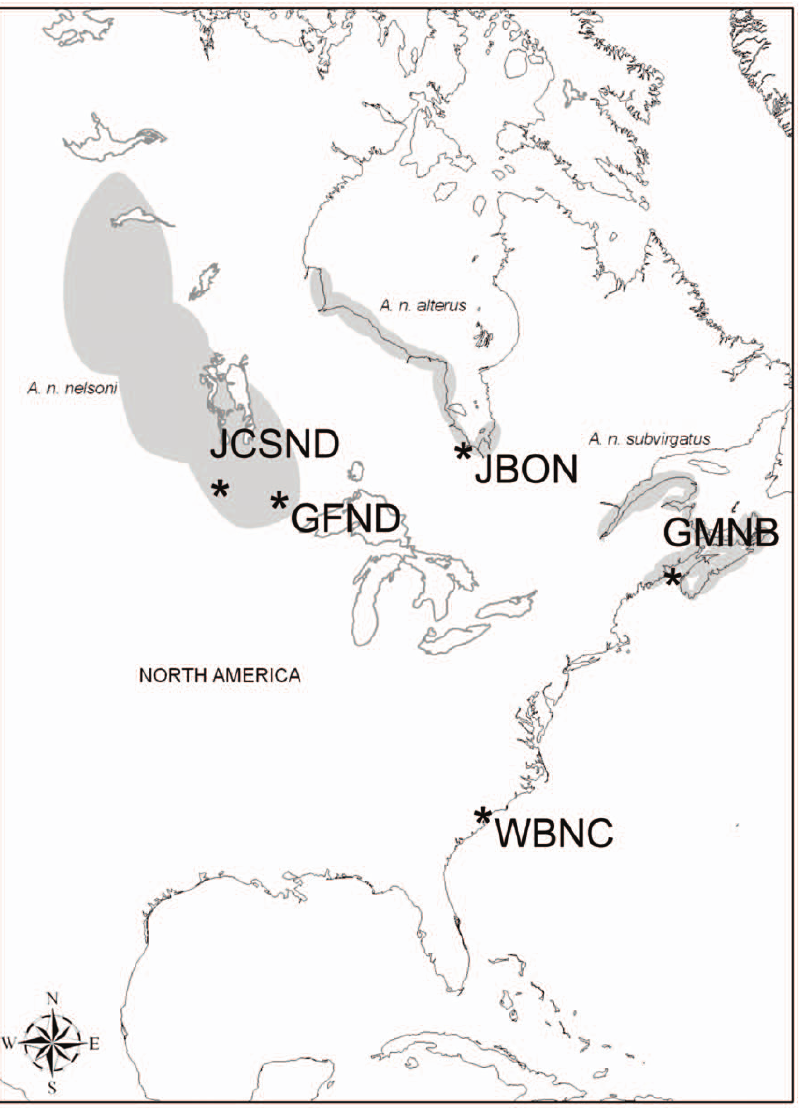
Figure 1. Map of breeding ranges (gray shading) for each subspecies of Nelson’s Sparrow. Capture locations are noted with asterisks (*). GFND represents captures near Grand Forks, ND, USA (47 u 54 9 7.90 0 N, 97 u 17 9 55.31 0 W); GMNB represents captures from Grand Manan Island, New Brunswick (44 u 42 9 0.00 0 N, 66 u 47 9 60.00 0 W); JBON represents captures from the shore of James Bay north of Moosonee, Ontario, Canada (51 u 21 9 36.53 0 N, 80 u 25 9 27.79 0 W); JCSND represents captures at J. Clark Salyer National Wildlife Refuge near Upham, ND (48 u 37 9 7.04 0 N, 100 u 42 9 21.41 0 W); and WBNC represents pooled data from non-breeding captures of all three subspecies near Wrightsville Beach, NC (34 u 10 9 34.68 0 N, 77 u 50 9 22.26 0 W). [Source for subspecies ranges: http://bna .cornell.edu/bna/species/719/articles/introduction doi:10.2173/].